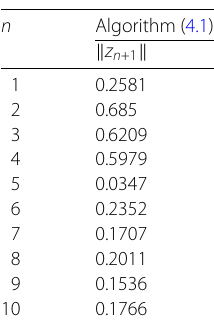
Table 4 Numerical results for Example